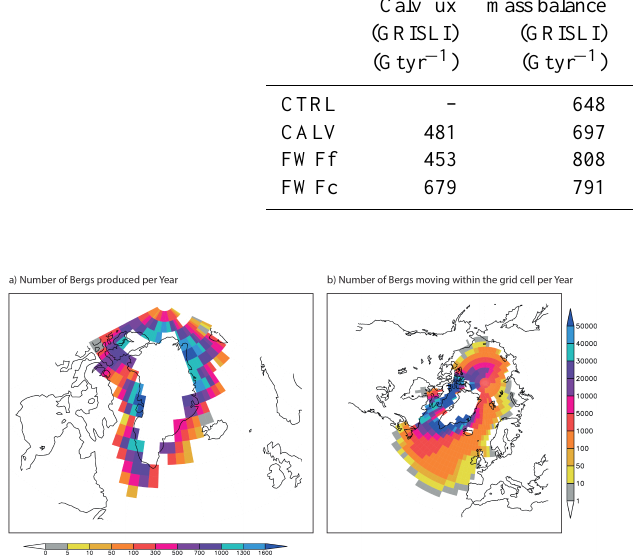
Figure 6. (a) Number of icebergs being generated per year; (b) number of icebergs moving within a grid cell per year. Icebergs moving within one grid cell for a longer period are counted more than once (non-linear colour